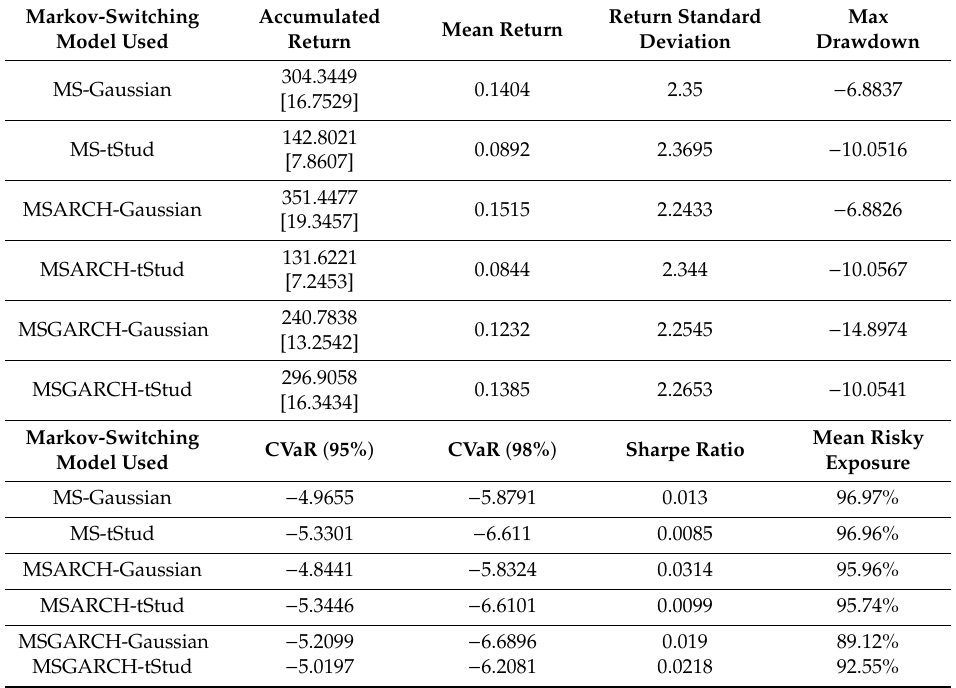
Table 8. Performance summary of the Markov-Switching investment strategy applied in the Chilean stock market (from a U.S. dollar-based investor